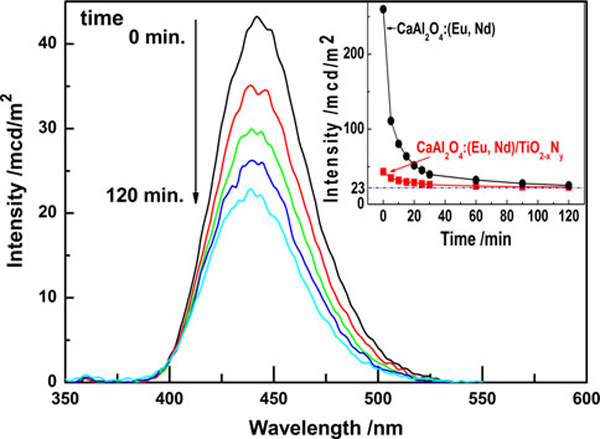
The emission decay profile of CaAl2O4:(Eu, Nd)/TiO2-xNy composite after irradiation by the mercury lamp used for photocatalytic reactions. The inset shows the decline of the intensity of the emission.